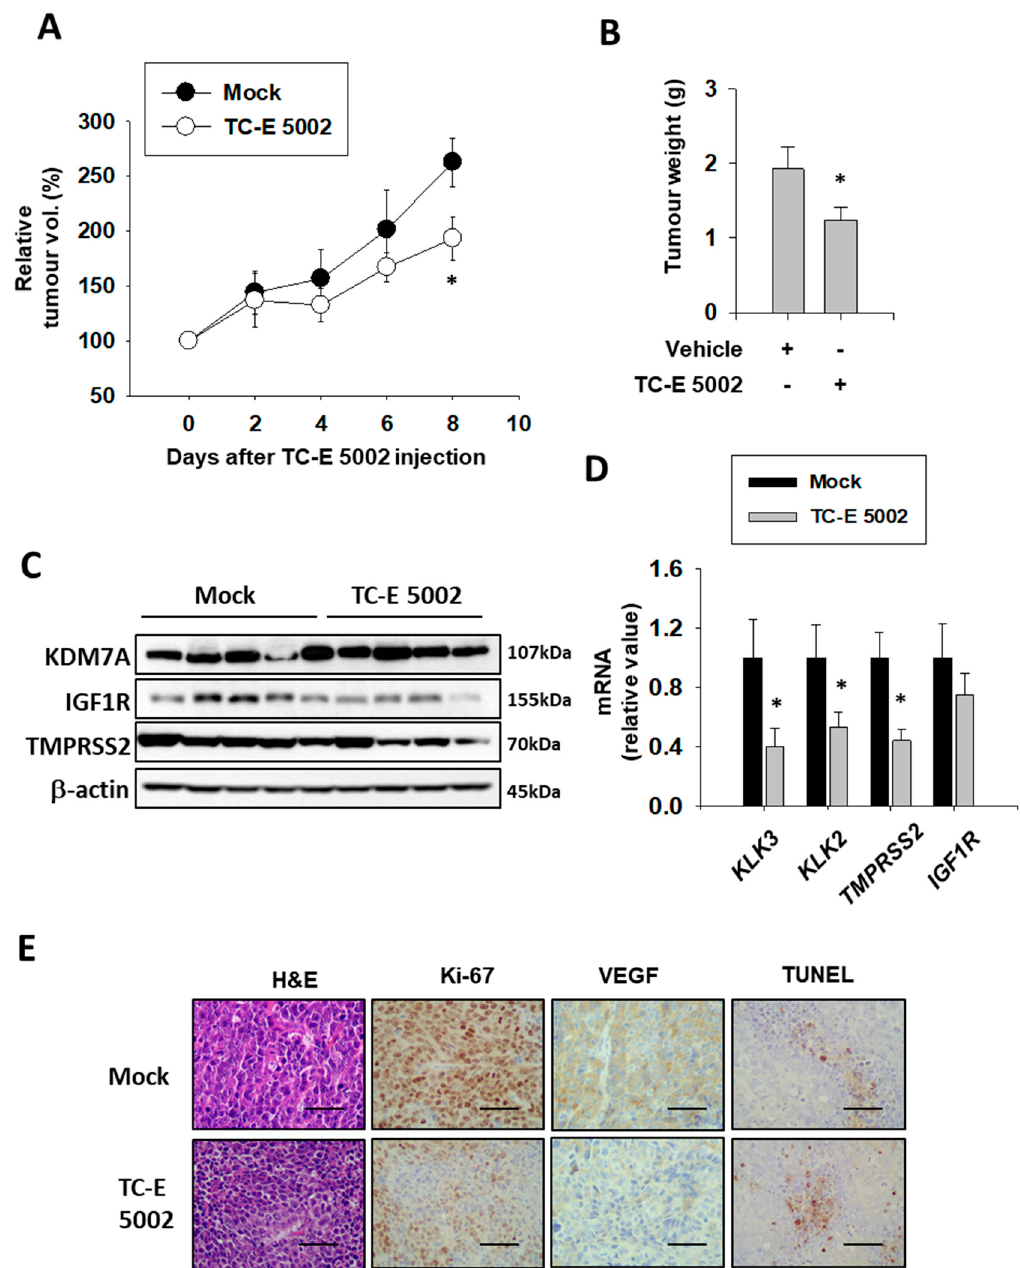
Figure 7. Effect of TC-E 5002 treatment on bladder tumor growth in the xenograft model in NSG mice. ( A ) Relative tumor volume in animals treated with vehicle or TC-E 5002 (10 mg/kg per day). Intraperitoneal drug treatment was started when the average tumor volume reached 200 mm 3 and continued every day for 8 days. Error bars represent means ± SEM for each group ( n = 5). * p < 0.05 (Student’s t -test) versus the vehicle-treated group. ( B ) Weight of tumors excised from animals treated with the vehicle or TC-E 5002. Error bars represent means ± SEM for each group ( n = 5). * p < 0.05 (Student’s t -test) versus the vehicle-treated group. ( C ) Total protein was extracted from each xenografted tumor, and Western blotting was performed using the indicated antibodies. ( D ) Total RNA was extracted from each xenografted tumor, and the indicated mRNA levels were measured. Bars represent means ± SEM for each group ( n = 5). * p < 0.05 (Student’s t -test) versus the vehicle-treated group. ( E ) Representative hematoxylin-eosin staining and immunohistochemistry images of the excised tumors. Scale bar is 20 μ m.